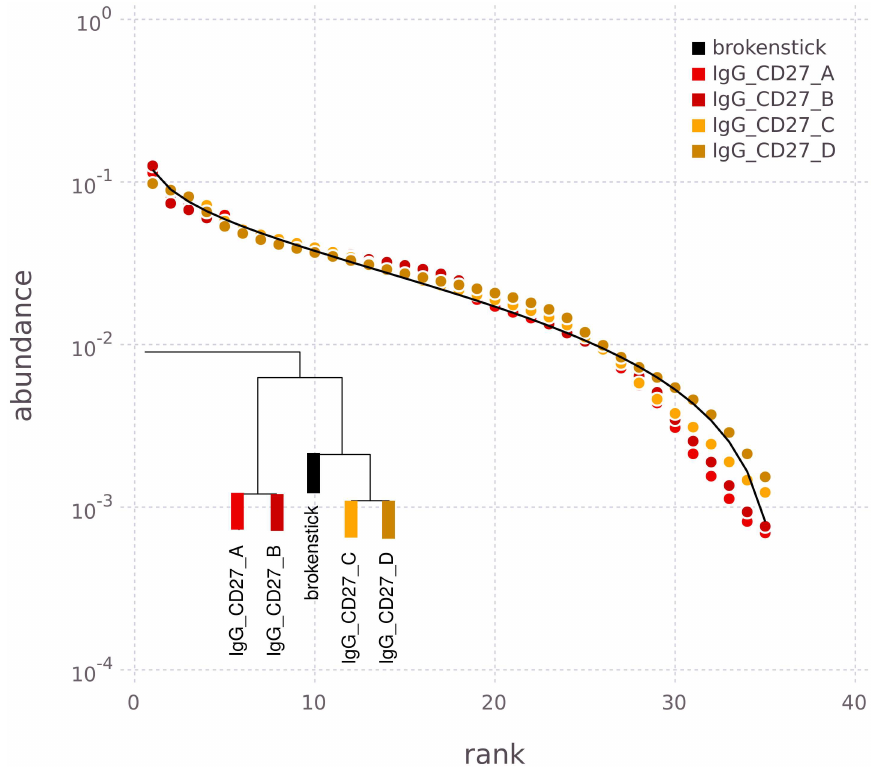
Fig 5. Broken stick distribution (solid line) and NRADsof IgG + CD 27 + fractions (points). Inset: section of hierarchical clustering dendrogram where brokenstick distributionappears. This plot adopts the usual presentation of the brokenstick distributionin the literaturewith linear horizontalaxis and logarithmicvertical axis. Therefore the boomerang shapes of the log-logFig 4 appearhorizontally